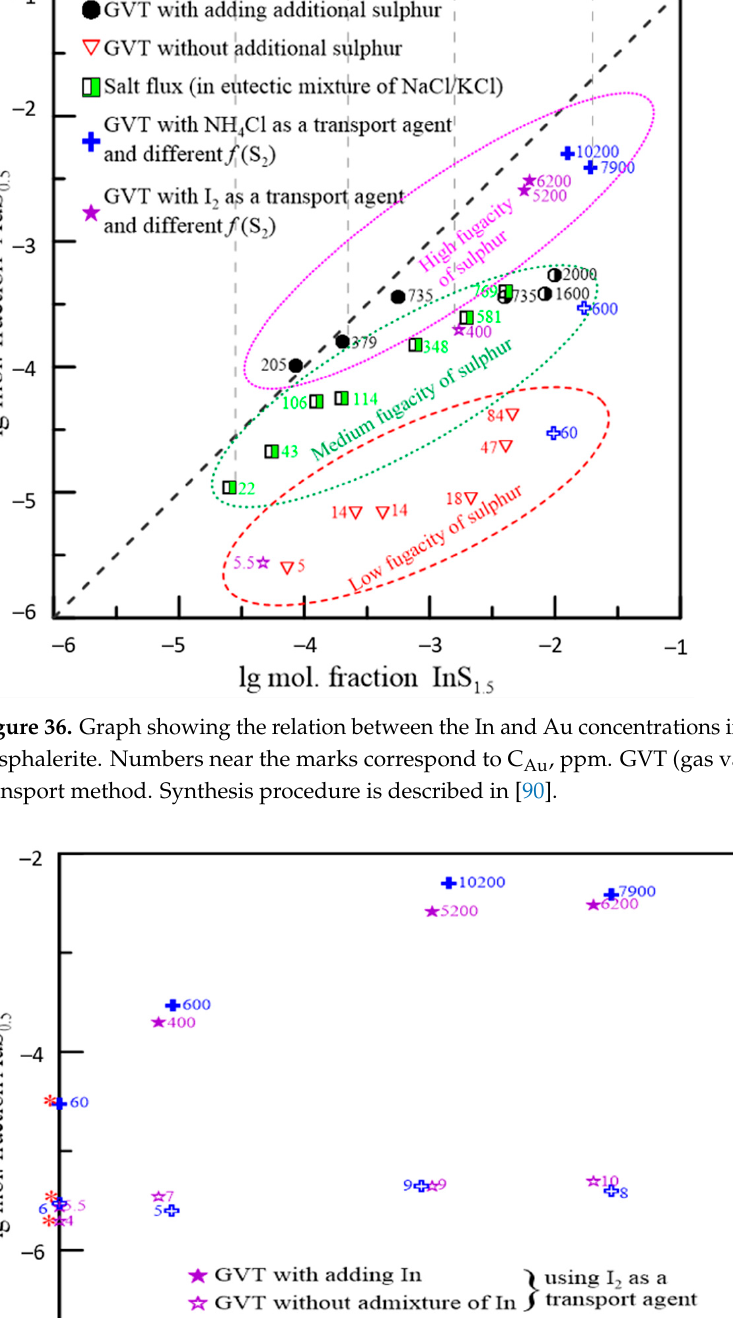
Figure 37. Chemical composition (in mol. fraction AuS 0.5 ) of sphalerite crystals doped in In and